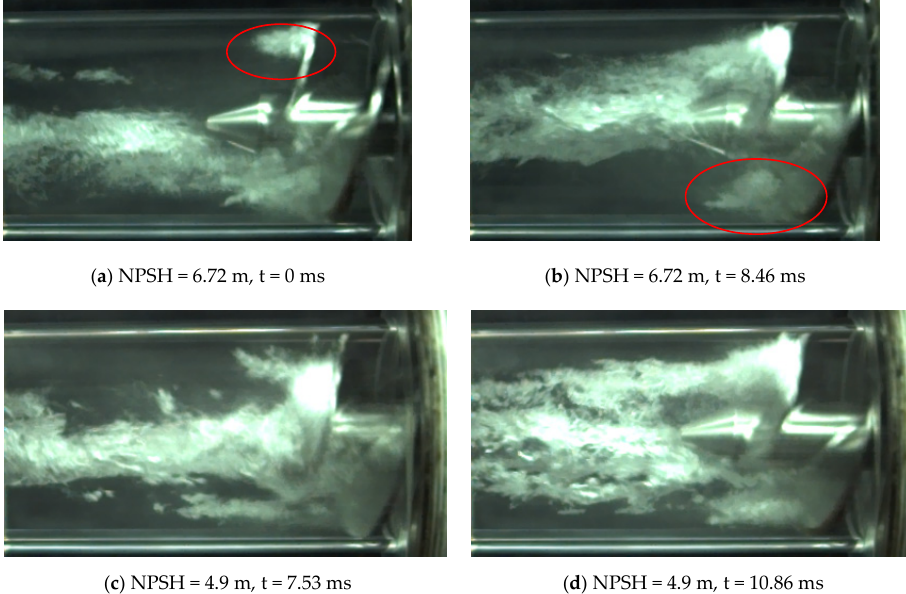
Figure 12. Vortex distribution under different NPSH (Q = 0.27 Q d ).